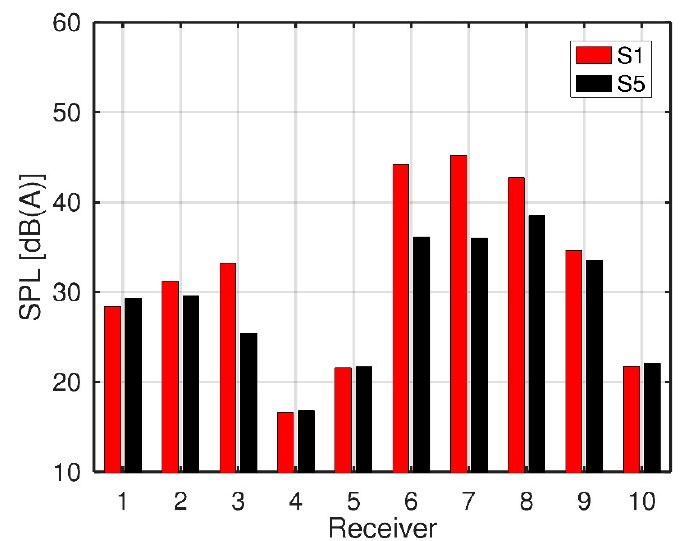
Figure 12. Noise levels predicted in each receiver—Ln only with roof noise sources (red: Scenario 1, black: Scenario 5).